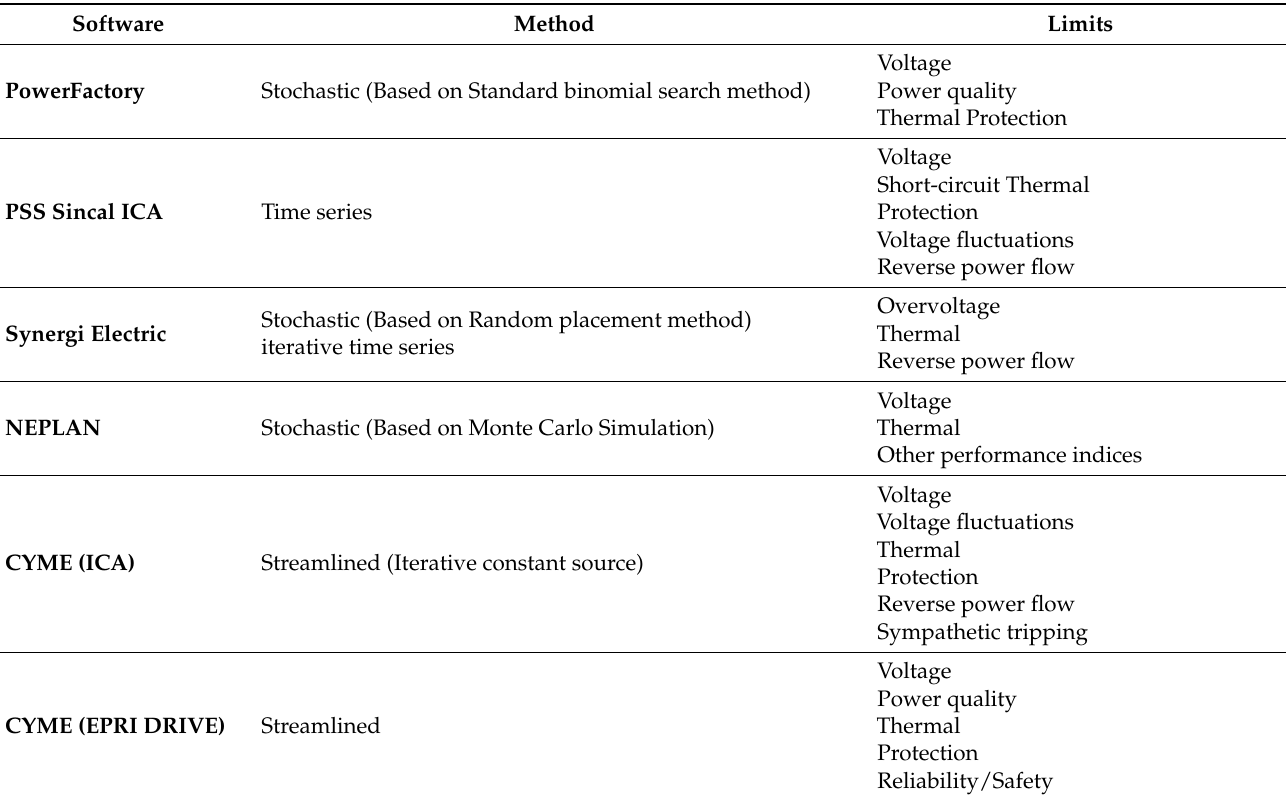
Table 10. Summary of HC evaluation Software